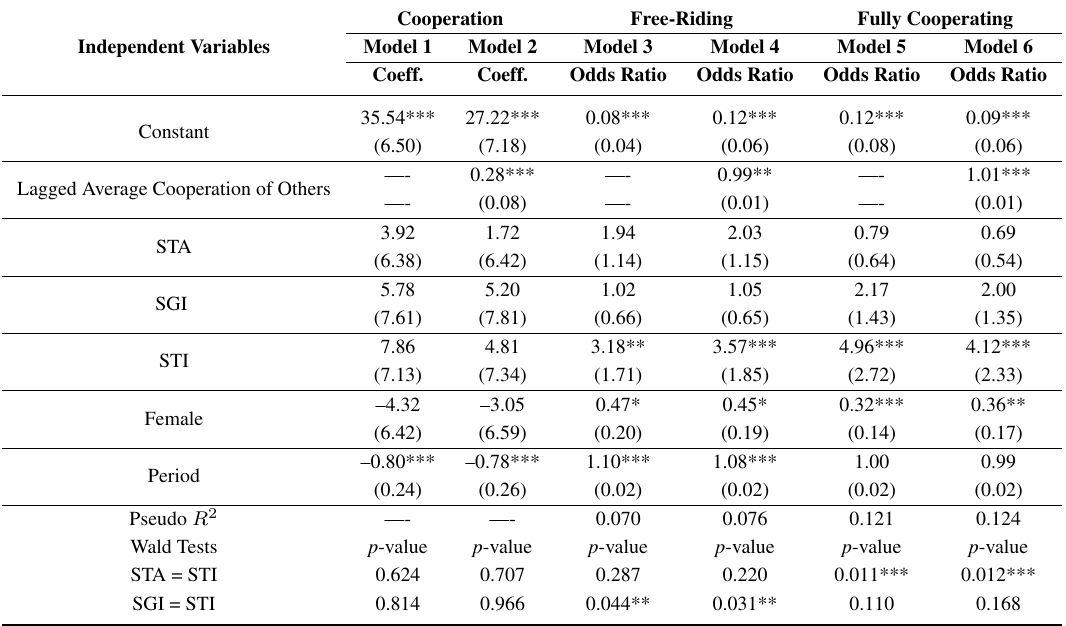
Table 5. Individual-Level Regressions: Average Cooperation, Free-Riding, and Fully Cooperating